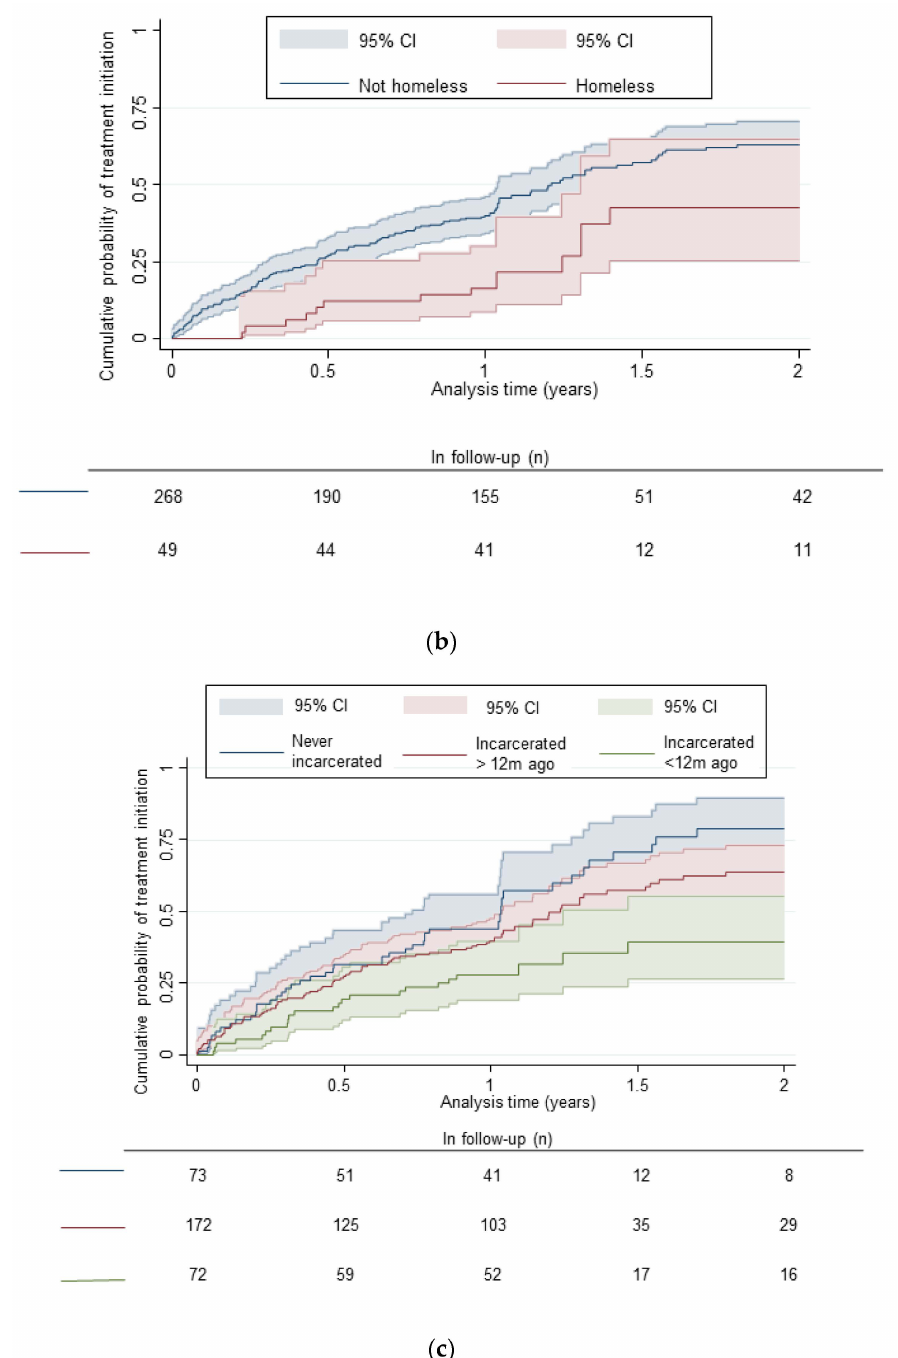
Figure 1. ( a ) Kaplan-Meier curves depicting estimated time (years) to DAA treatment initiation among people diagnosed with current HCV infection in ETHOS Engage overall. ( b ) Kaplan-Meier curves depicting estimated time (years) to DAA treatment initiation among people diagnosed with current HCV infection in ETHOS Engage by homelessness. ( c ) Kaplan-Meier curves depicting estimated time (years) to DAA treatment initiation among people diagnosed with current HCV infection in ETHOS Engage by history of